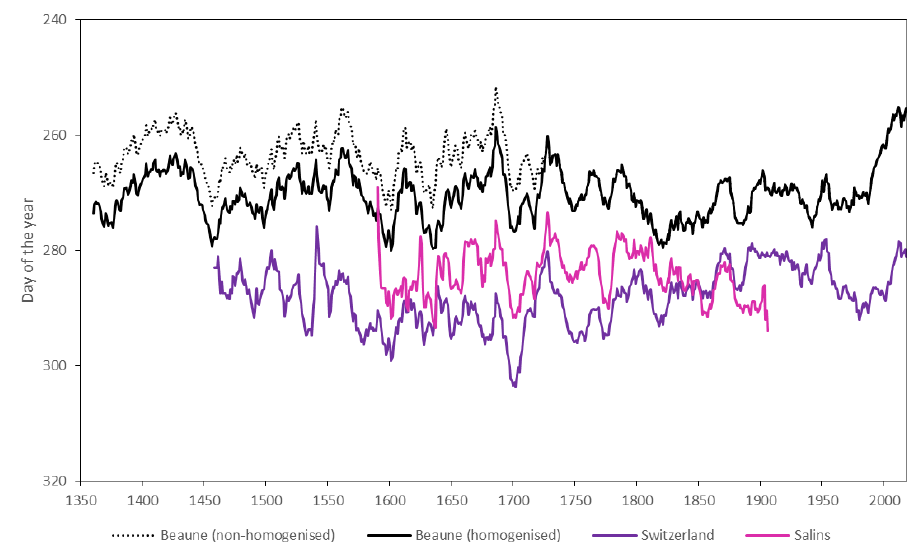
Figure 5. An 11-year low-pass-filtered GHD series of Beaune (homogenised and non-homogenised), Switzerland (Wetter and Pfister, 2013) and Salins (Angot, 1885). Table 1. Comparison of mean GHD time series in Beaune (this article), Aubonne (Angot, 1885), Salins (Angot, 1885), Switzerland (Wetter and Pfister, 2013) and Czech lands (Možný et al., 2016). Period 1: Period